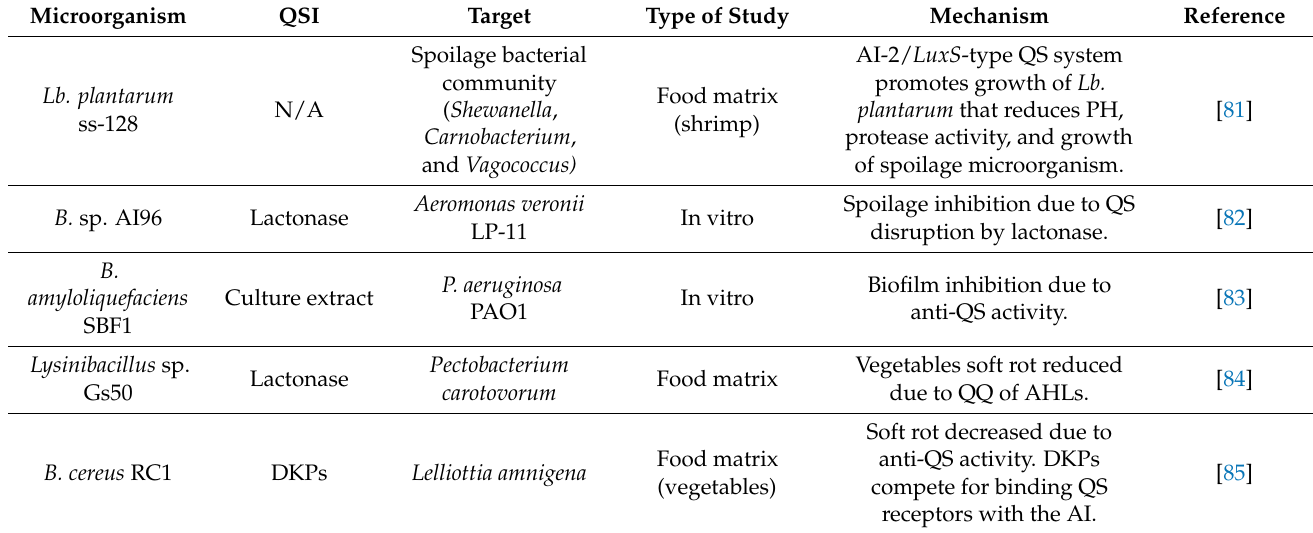
Table 2. Probiotics involved in the inhibition of QS mechanisms of food spoilage bacteria.